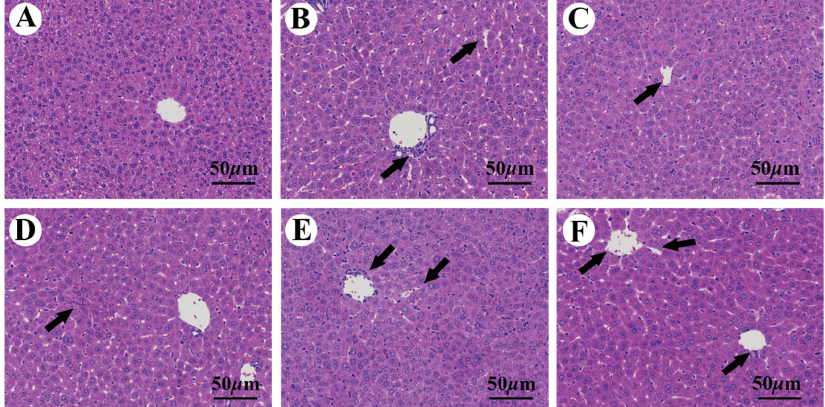
Figure 6. Images of liver damage stained by H&E (magnification: ×200). ( A − F ) represent the control, ConA, DIG, AaEA-L, AaEA-M, and AaEA-H groups, respectively. The cells’ disorder arrangement and infiltration of inflammatory cells are demonstrated by black arrows.